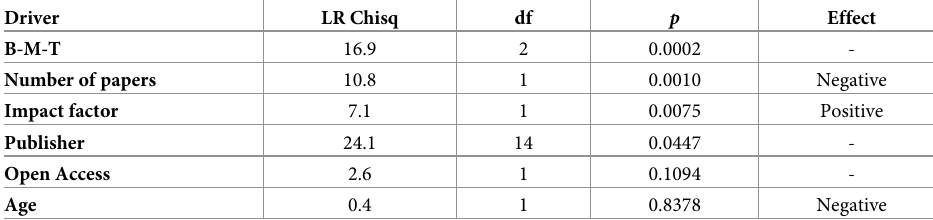
Table 1. Potential drivers of the proportion of papers with accessible data for each journal. Driver LR